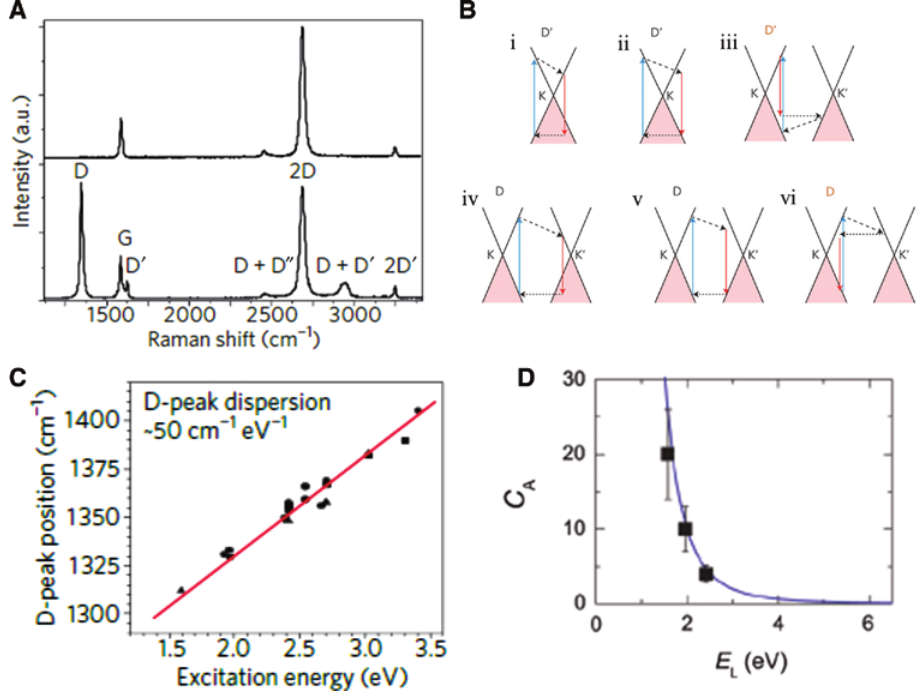
Figure 3: (A) Raman spectra of pristine (top) and defective (bottom) graphene. (B) Raman processes corresponding to D and D ′ peaks of graphene. Electron dispersion (solid black lines), occupied states (shaded areas), interband transitions neglecting the photon momen- tum, accompanied by photon absorption (blue arrows) and emission (red arrows), intraband transitions accompanied by phonon emission (dashed arrows), and electron scattering on a defect (horizontal dotted arrows). (C) Measured and calculated frequencies of the D peak as a function of the excitation energy. Reprinted with permission from [45]. Copyright 2013 Nature Publishing Group. (D) Laser energy depend- ∝ C ∝ E L−4 fit. Reprinted with permission from [92]. ence of the integrated Raman intensity ratio I /I , where I /I . The solid line is given by C D G D G A A Copyright 2011 American Chemical